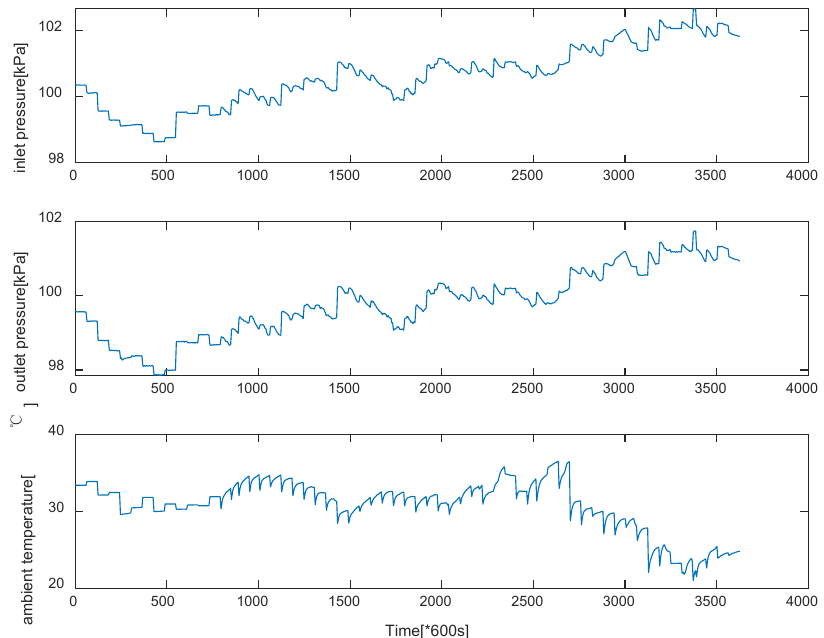
Figure 5. Performance degradation test curves of intake filter.